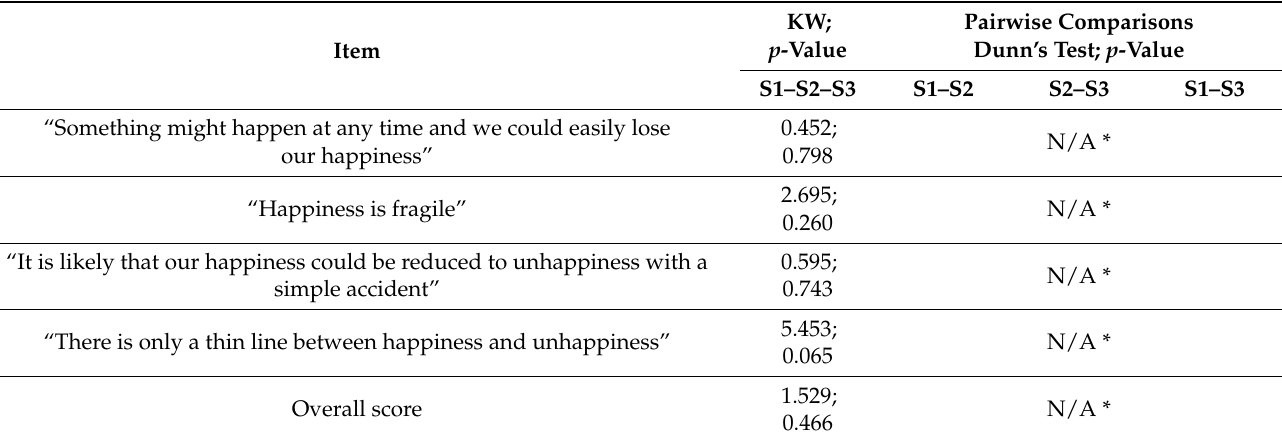
Table 6. Results of the